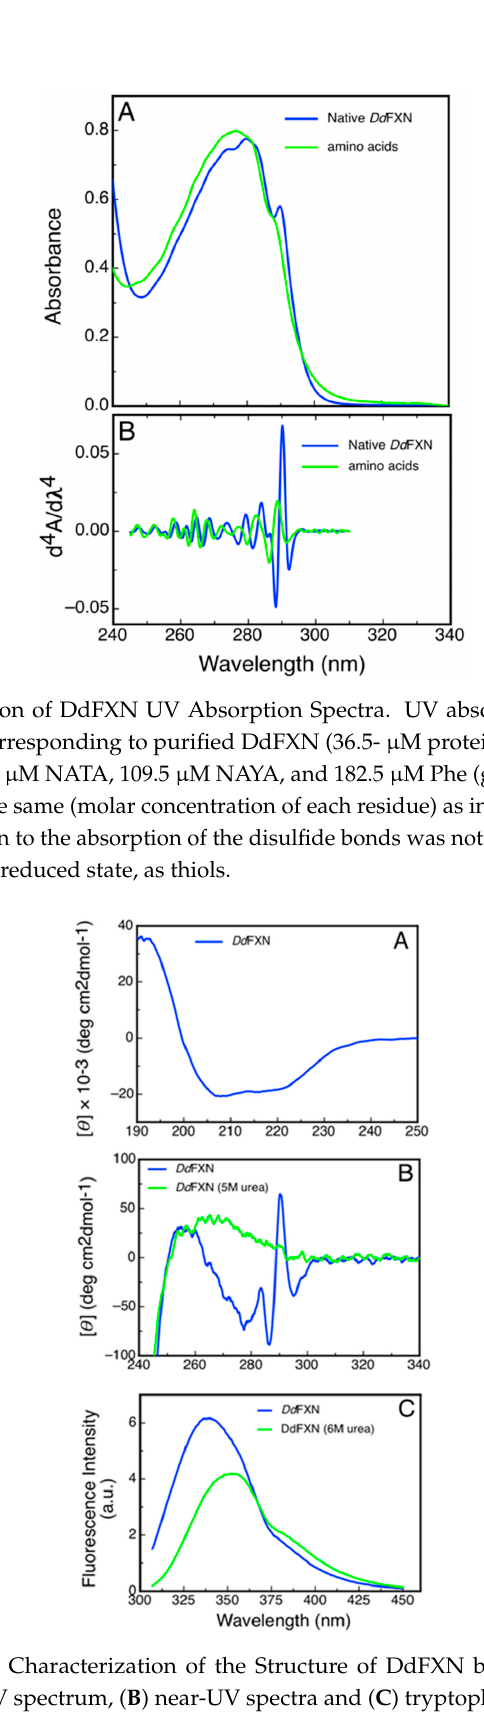
Figure 7. Spectroscopic Characterization of the Structure of DdFXN by Circular Dichroism and Fluorescence. ( A ) Far-UV spectrum, ( B ) near-UV spectra and ( C ) tryptophan fluorescence spectra of DdFXN. Protein concentration was 8, 30 and 3 µ M, respectively.